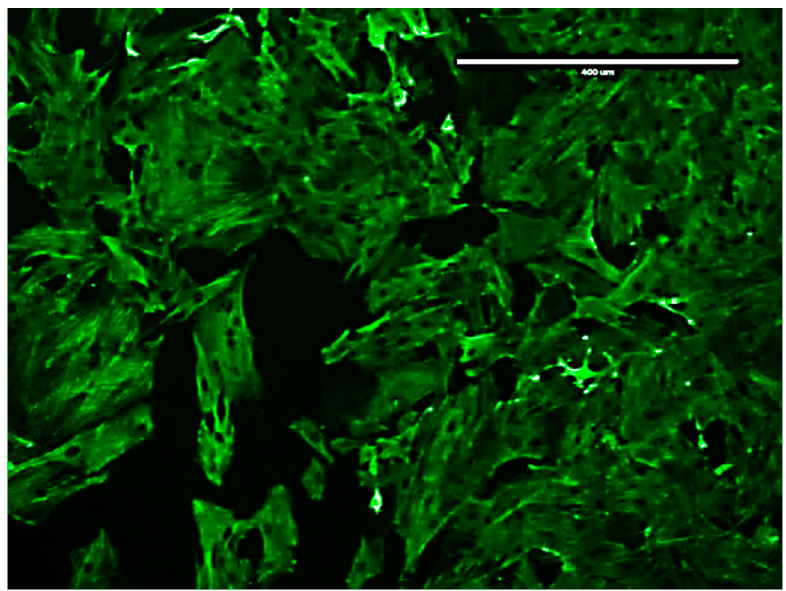
Figure A2. Immuno-stained microscopic image of rat aortic VSMCs depicting the presence of SM22 α actin fibers (scale bar: 400 μ m, magnification: × 10).